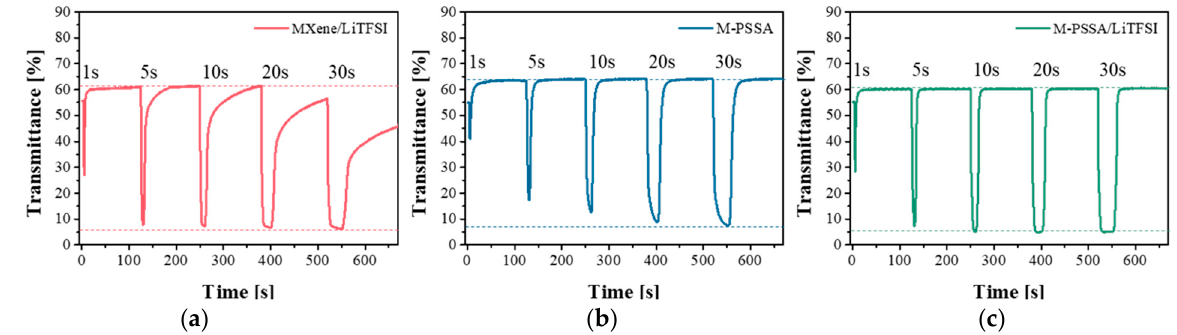
Figure 3. Transmittance vs. time of chronoamperometry at the wavelength of 600 nm of ( a ) MXene/Bis(trifluoromethylsulfonyl)amine lithium salt (MXene/LiTFSI), ( b ) poly(4-styrenesulfonic acid) crosslinked with MXene (M-PSSA) and ( c ) 1:20 LiTFSI in MXene-PSSA(M-PSSA/LiTFSI). Applied square-wave potential between − 1.2 V (1, 5, 10, 20 and 30 s) and 0.5 V (120 s).